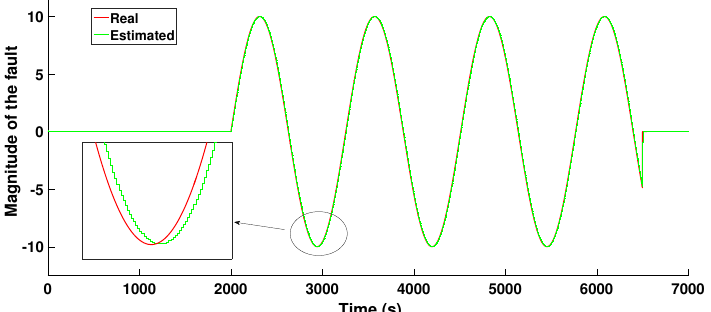
Figure 23. Scenario 2 − Individual fault: Real and estimated sine wave-type fault on the PSA virtual